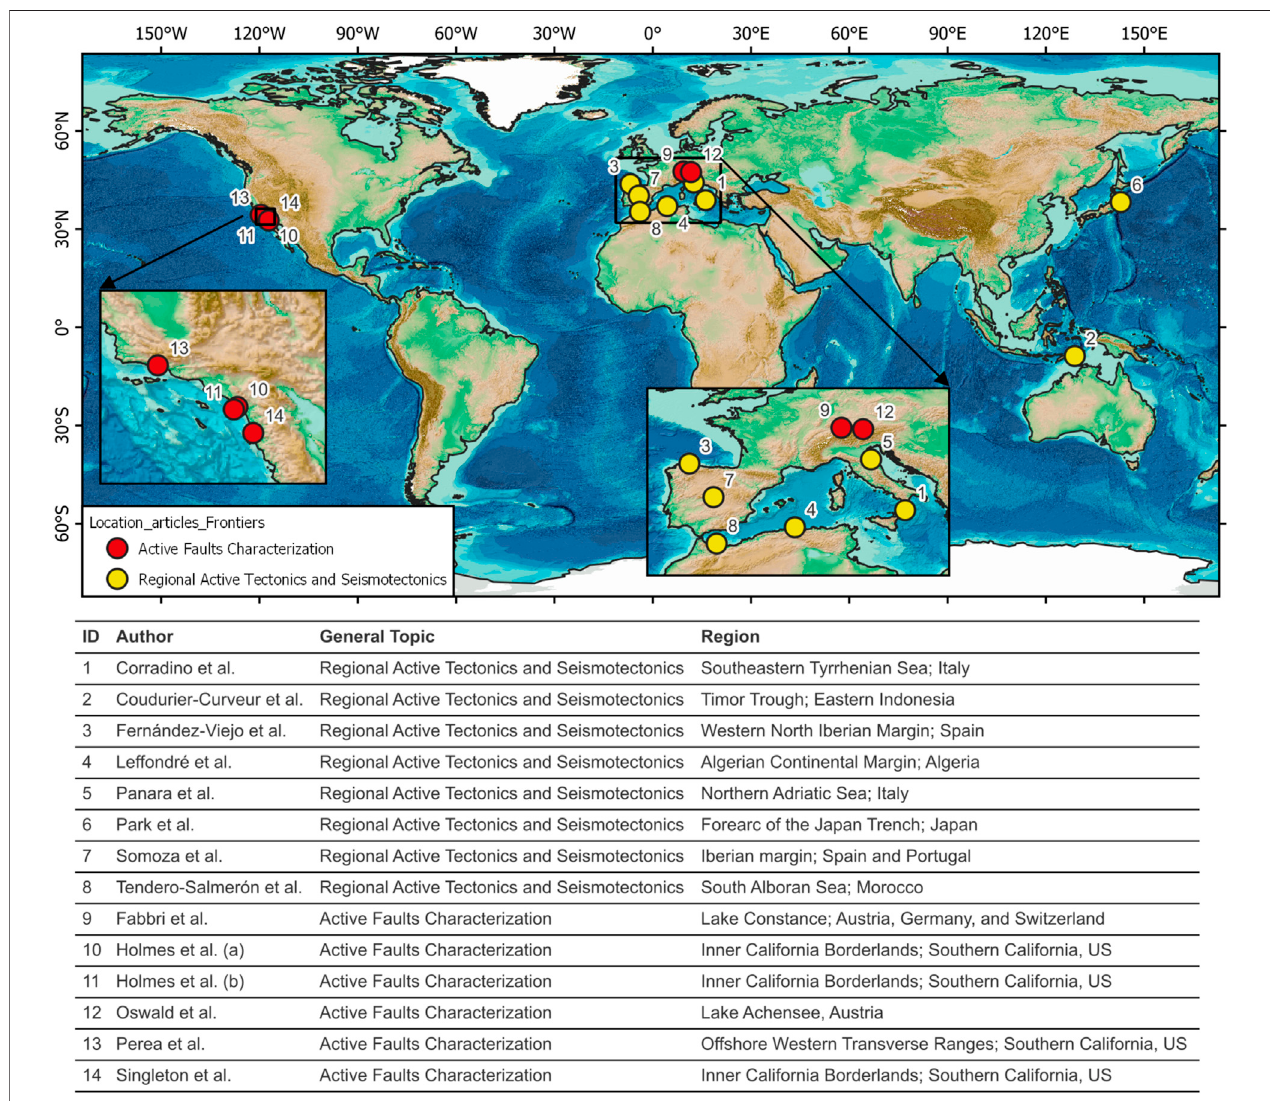
FIGURE 1 | Fourteen contributions (1 – 14) have been published as a part of the Frontiers in Earth Sience Research Topic Submarine Active Faults: From Regional Observations to Seismic Hazard Characterization. The insets enlarge areas corresponding to Southern California (US) and Europe. The table provide information about the authors, the general topic covered in the publication and the region focus of the study. The map corresponds to the GEBCO ’ s gridded bathymetric data sets global terrain models for ocean and land (https://www.gebco.net/).